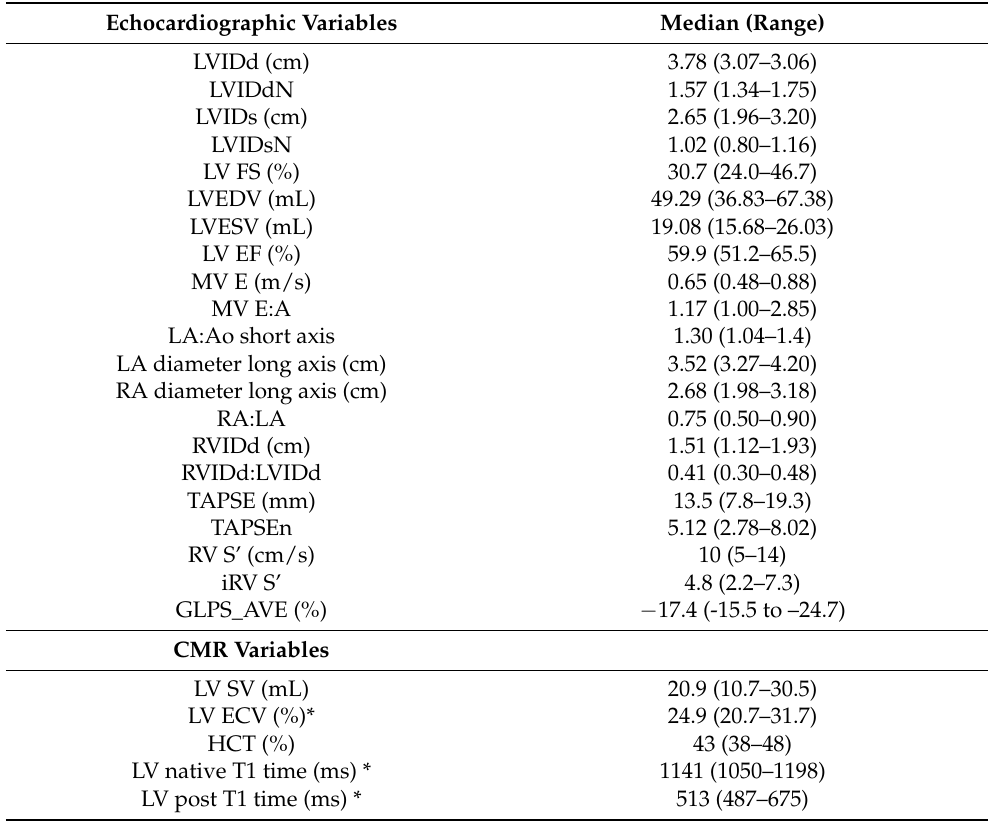
Table 2. Echocardiographic and cardiac magnetic resonance (CMR) imaging variables in 10 naturally infected dogs with chronic Chagas